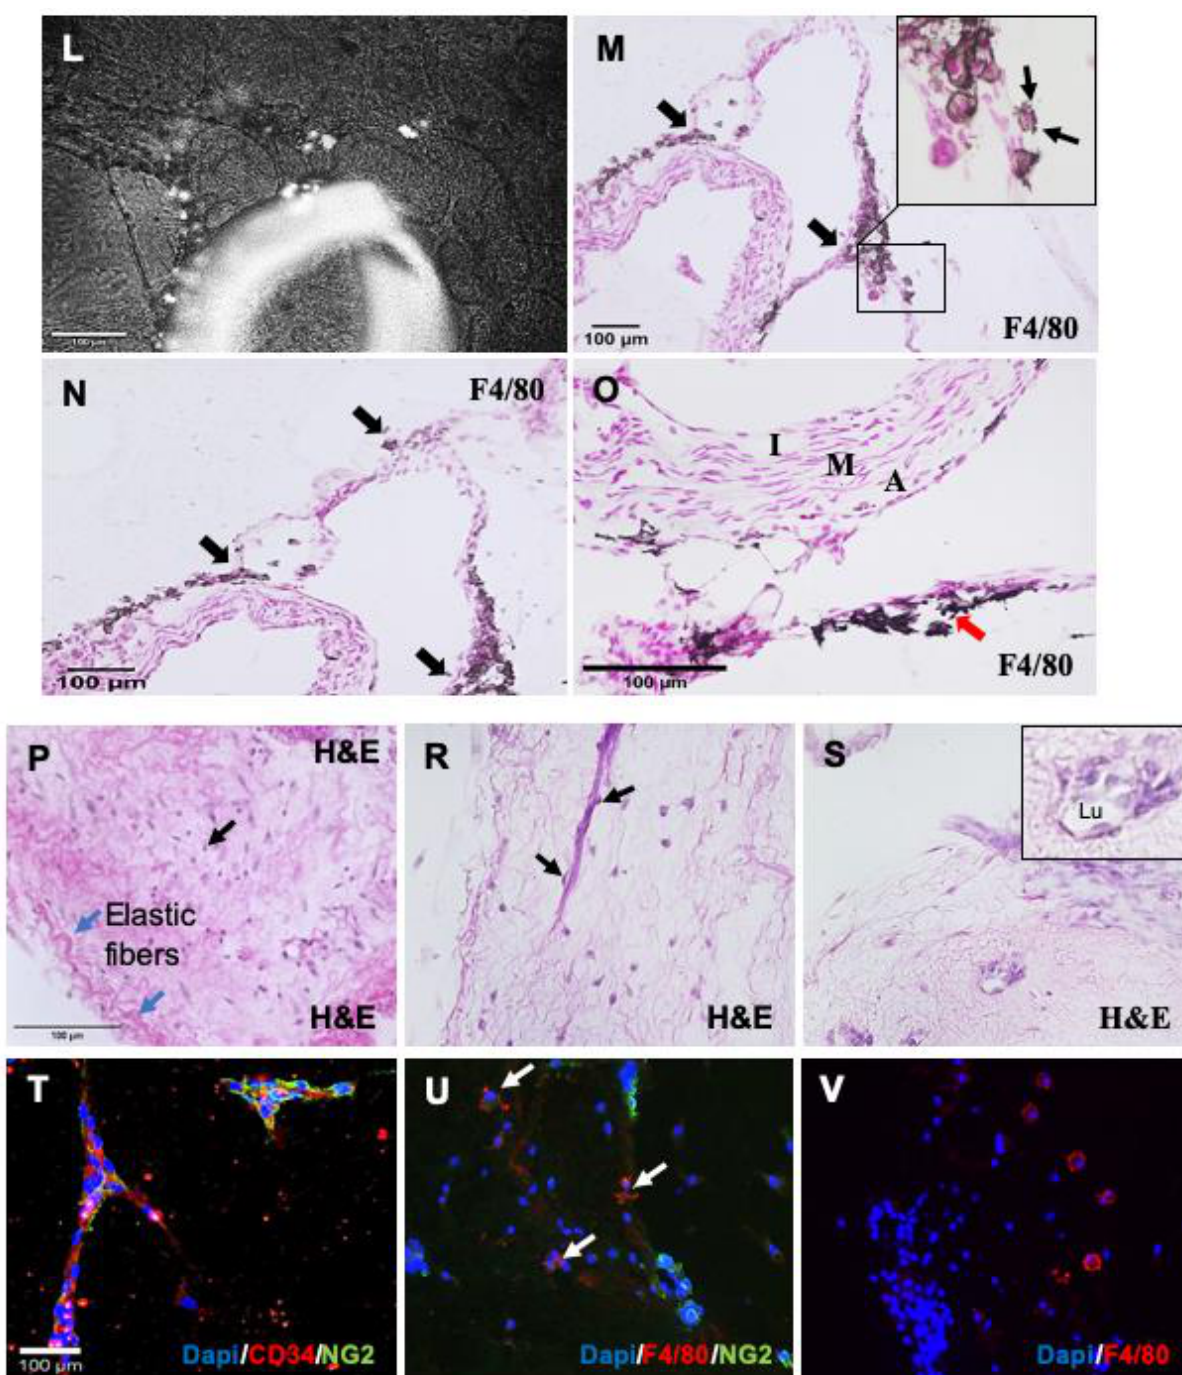
Figure 3. Vascular adventitia harbors sprouting-relevant cell types. Whole-mount staining of ARA and mdARA on day 7, for NG2 (pericytes (green)) and CD34 (endothelial and hematopoietic progenitor cells (red)). Confocal images: ( A , C ) in ARA more NG2 + cells are visible than in mdARA ( B , D ). Quantification of NG2 + and CD34 + cells from A and B ( E , F ). Staining for F4/80 + cells (yellow) in freshly isolated aorta ( G ). ARA ( H ) and mdARA ( I ) after 7 days of cultivation. F4/80 + cells are absent in the freshly isolated aorta, but appear within the adventitia during cultivation. A subset of F4/80 + cells stain positive for VEGF-A ( J , K ). ARA (aorta from Cx3cr1 CreER+/mTmG+/- reporter mice): fluorescent marked cells in non-fixed live images ( L ) and DAB immunostaining on paraffin section of ARA demonstrated the presence of F4/80 + cells in the regions of branching points (arrows) of capillary sprouts ( M – O ). H&E staining of freshly isolated adventitia shows cells (arrows) in an inactive state ( P ). After cultivation in collagen for 7 days, capillary-like sprouts (arrows) become visible ( R ) with observable lumen (Lu) formation ( S ). Capillary-like sprouts are composed of CD34 + and NG2 + cells ( T ). Along sprouts, F4/80 + cells are visible ( U , V ). Error bars indicate SD. * p ≤ 0.05, ** p ≤